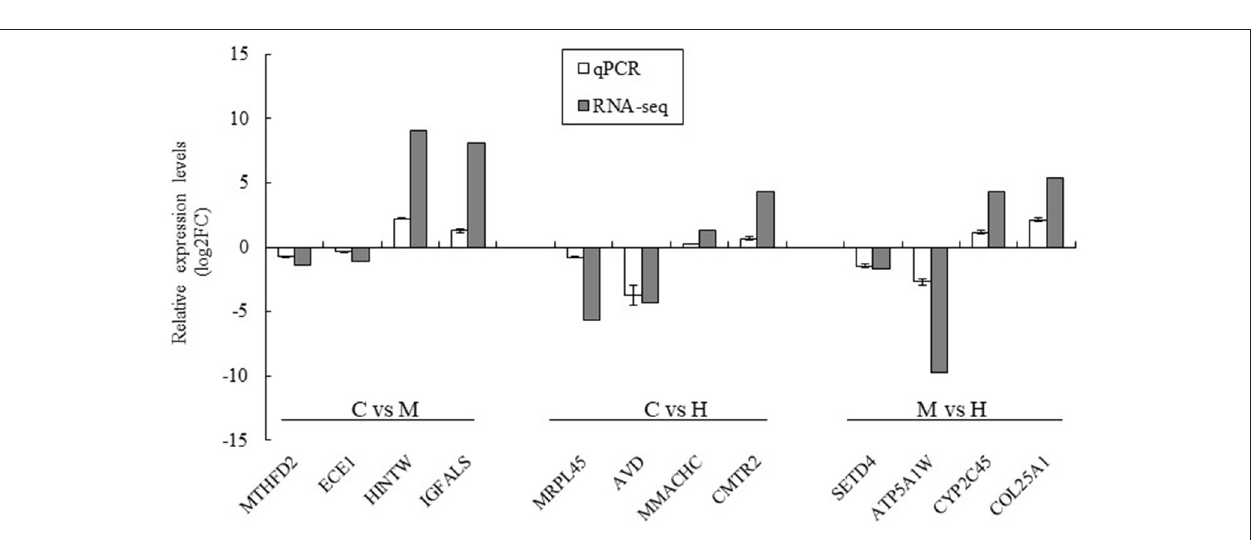
FIGURE 6 | Validation of the RNA-seq results using qPCR analysis. The data was based on the fold of change of qPCR and log 2 FC of RNA-seq. MTHFD2 and ECE1 were downregulated genes and HINTW and IGFALS were upregulated genes in C vs. M groups; MRPL45 and AVD were downregulated genes and MMACHC and CMRT2 were upregulated genes in C vs. H groups; SETD4 and ATP5A1W were downregulated genes and CYP2C45 and COL25A1 were upregulated genes in M vs. H